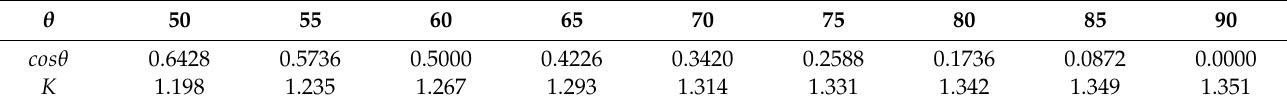
Table 1. Value of K for various of θ .